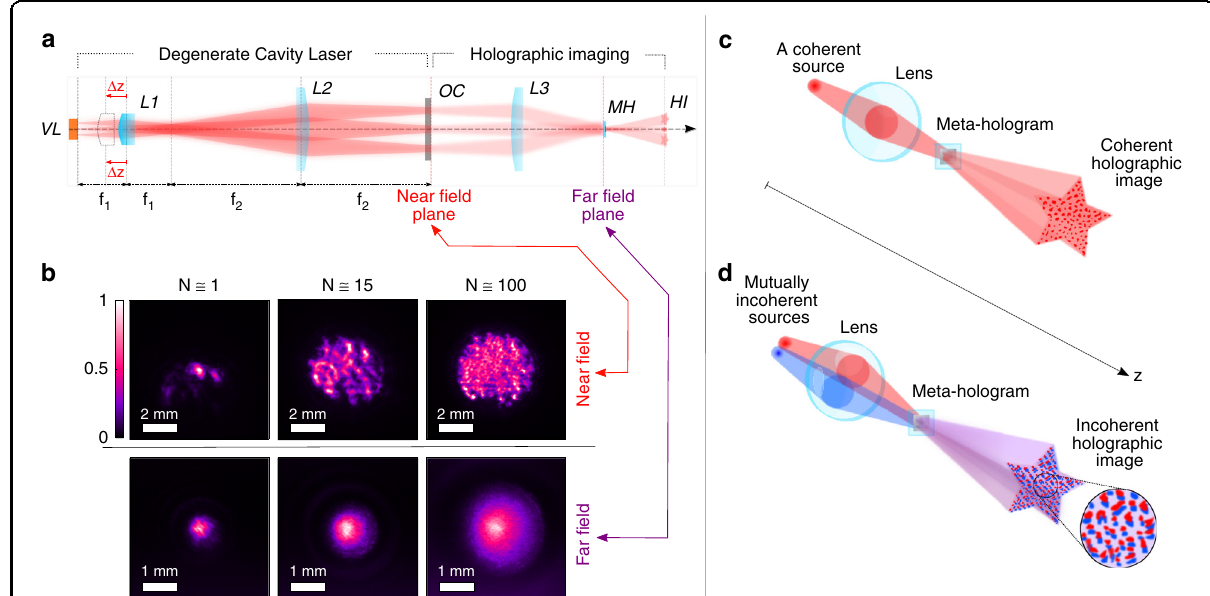
Fig. 2 Tuning the spatial coherence with a degenerate cavity laser (DCL). a Schematic of the DCL comprising of a vertical external cavity surface emitting laser (VECSEL) module (VL), two lenses (L1, L2), and an output coupler (OC). The far- fi eld DCL emission is projected by imaging optics (L3) onto the meta-hologram (MH), which creates a holographic image (HI) at its far- fi eld. L1 is gradually translated along the cavity axis to break the cavity degeneracy condition, so that the number of transverse lasing modes N decreases and the spatial coherence of the total emission increases. b Near- fi eld (top row) and far- fi eld (bottom row) intensity patterns of the total emission with a varying number N of transverse lasing modes. With increasing N , there are more bright spots in the near- fi eld (each corresponding to an independent lasing mode), and the far- fi eld pattern becomes larger. c Schematic of a single lasing mode illuminating the meta-hologram, creating intensity fl uctuations due to coherent artifacts. d Schematic of two mutually incoherent lasing modes illuminating the meta-hologram with different angles, creating laterally shifted and mutually incoherent holographic images. An incoherent (intensity) sum of the two images reduces the intensity fl